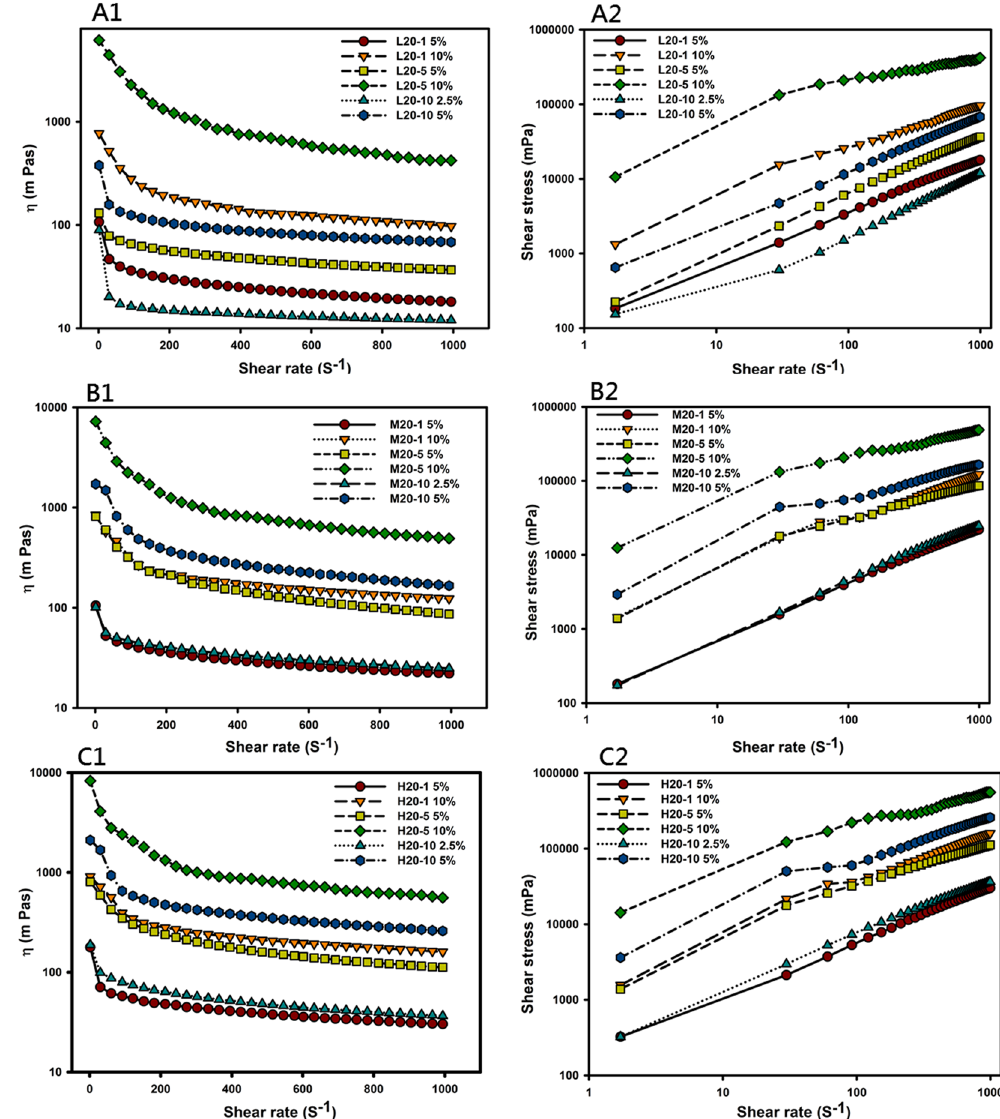
Figure 2. Dynamic viscosity ( η ) versus the shear rate ( γ  ) ( A1 , B1 and C1 ) or log shear stress ( τ ) versus the log shear rate ( γ  ) ( A2 , B2 and C2 ) for ring-opened polyvinyl pyrrolidone ( ro PVP)/chitosan (CS) hydrogels composed of ro PVP complexed with different molecular weights (Mws) of CS (( A1 and A2 ) low Mw, ( B1 and B2 ) medium Mw, ( C1 and C2 ) high Mw) at three ro PVP:CS ratios of 20:1, 20:5, and